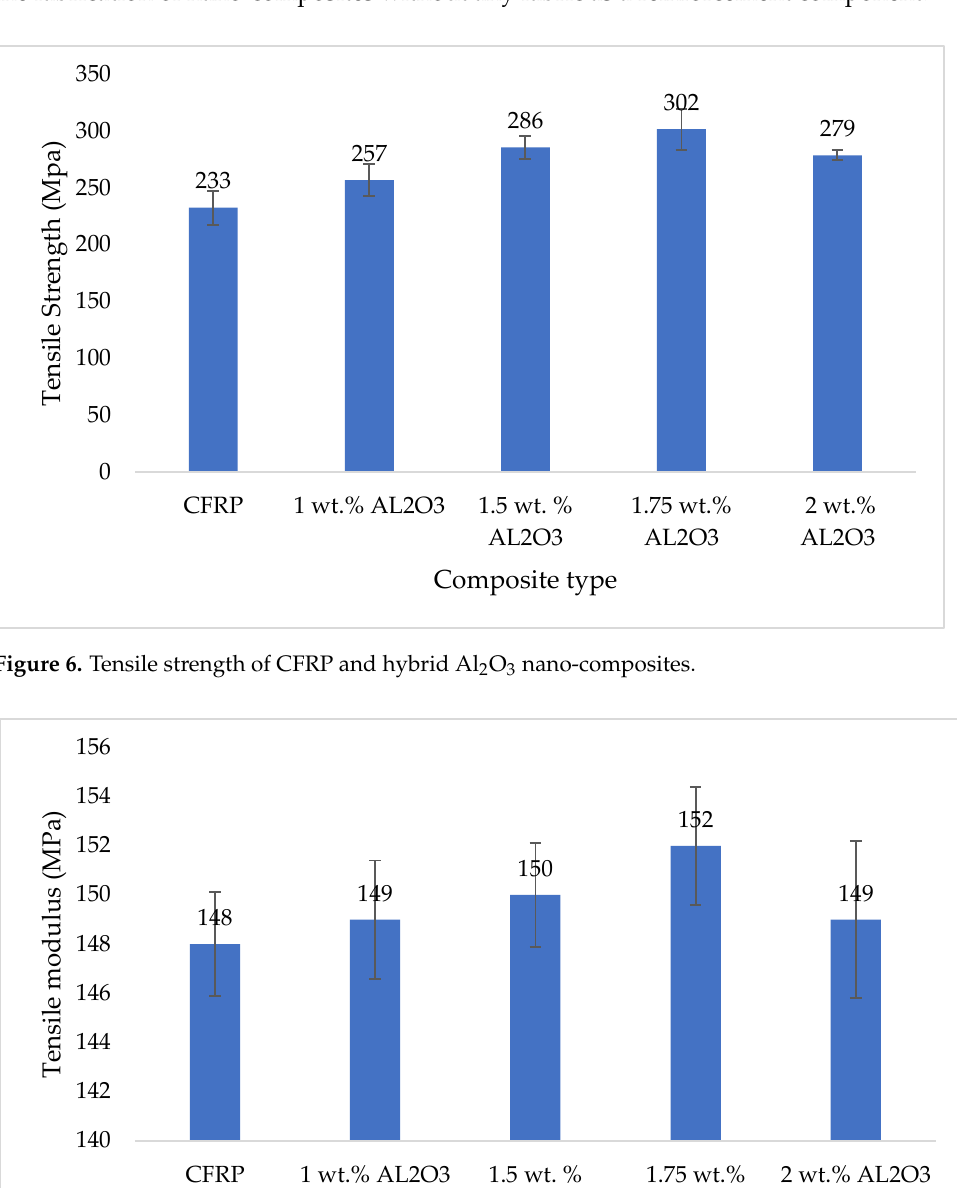
Figure 7. Tensile modulus of CFRP and hybrid Al 2 O 3 nano-composites.